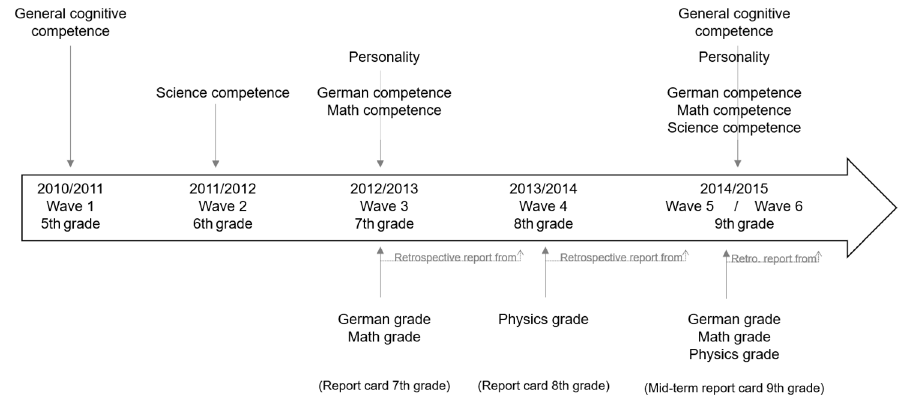
Figure 1. Overview of the timing of the assessment of the constructs.